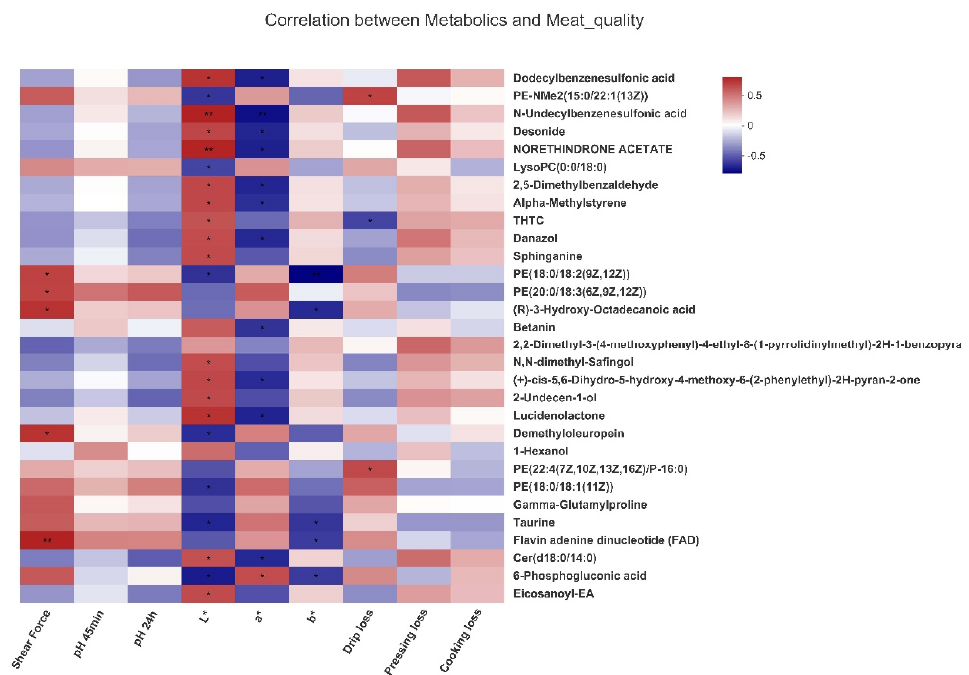
Figure 3. Correlations between longissimus thoracis muscle metabolites and meat quality traits ( − 20% group, n = 6). The top 30 metabolites were selected. Significance levels were marked as * for p < 0.05, ** for p < 0.01.